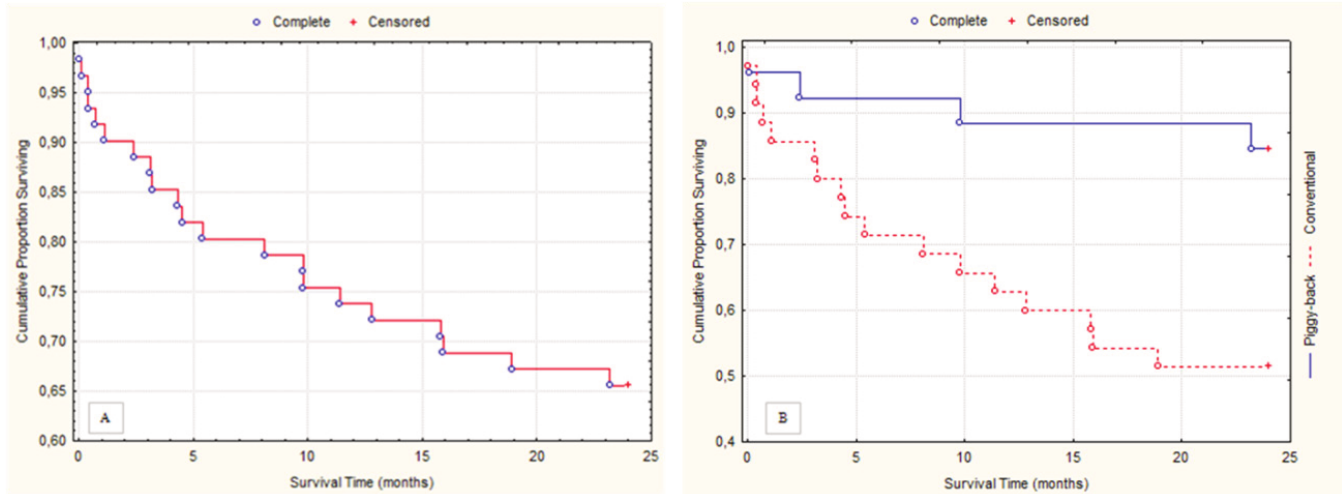
FIGURE 1 - Kaplan–Meier survival analysis (24 months) after liver transplantation to treatment of hepatocellular carcinoma. A. The 3-, 6-, 12- and 24-month overall cumulative survival were 88.5%, 80.3%, 73.8% and 65.6%, respectively. B. Analysis of patients stratified according to hepato- venous reconstruction technique showed higher cumulative survival amongst patient in which the piggy-back technique was applied (84.6% vs. 51.4%. p<0.01, by the log-rank